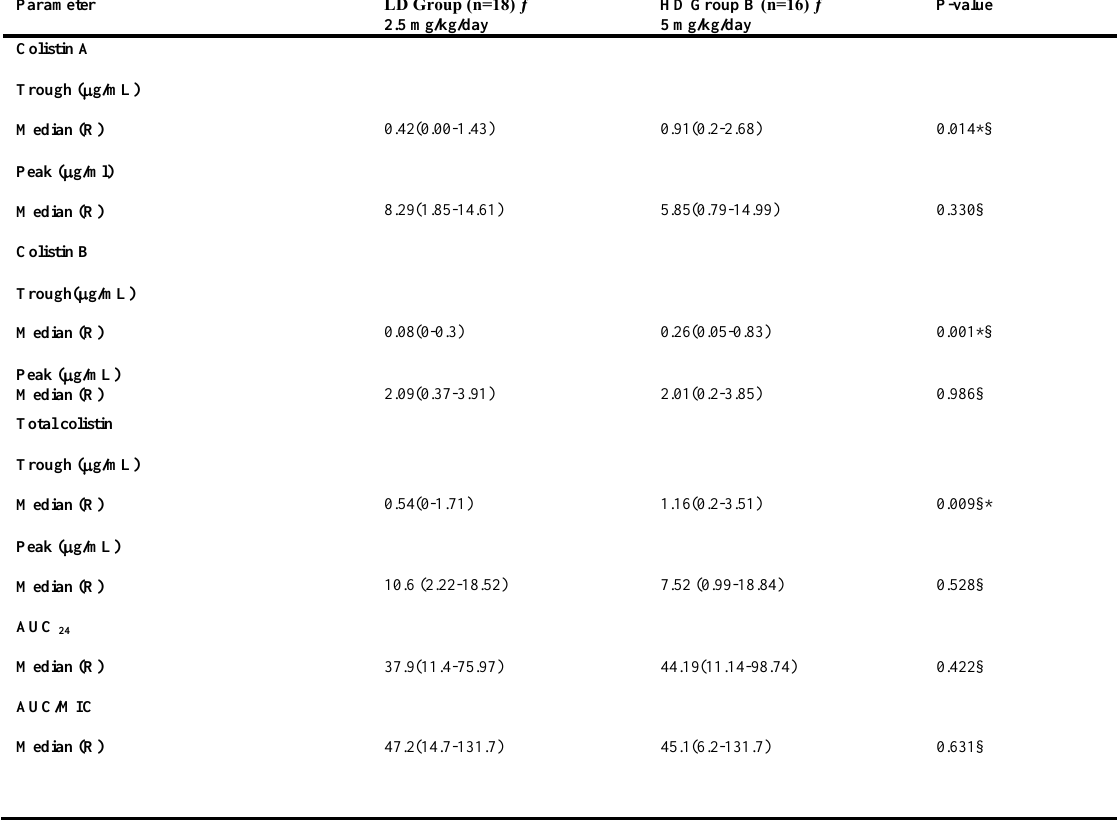
Table 3. Colistin pharmacokinetic parameters of Febrile Neutropenic Pediatric Cancer Patients treated with Colistin